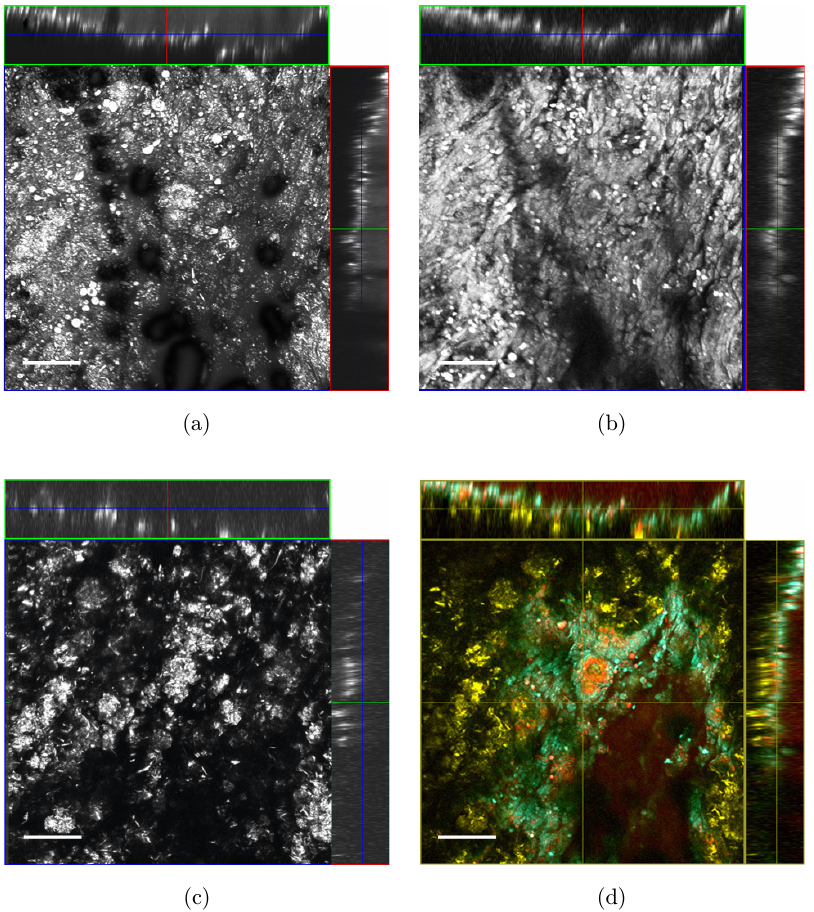
Fig. 3. CARS (a), TPF (b) and SHG (c) images of a plaque recorded as a z -stack of about 100 (cid:1) m into the tissue at a step size of 5 (cid:1) m. Image (d) is an overlay of all three signals, whereby the CARS signal is plotted in red, the TPF signal in cyan and the SHG signal in yellow. The ¯eld of view is 450 (cid:2) 450 (cid:1) m 2 . The scale bars are 100 (cid:1) m. Image intensity and contrast of the three images in (a), (b) and (c) were properly adjusted before merging them in the overlaid image